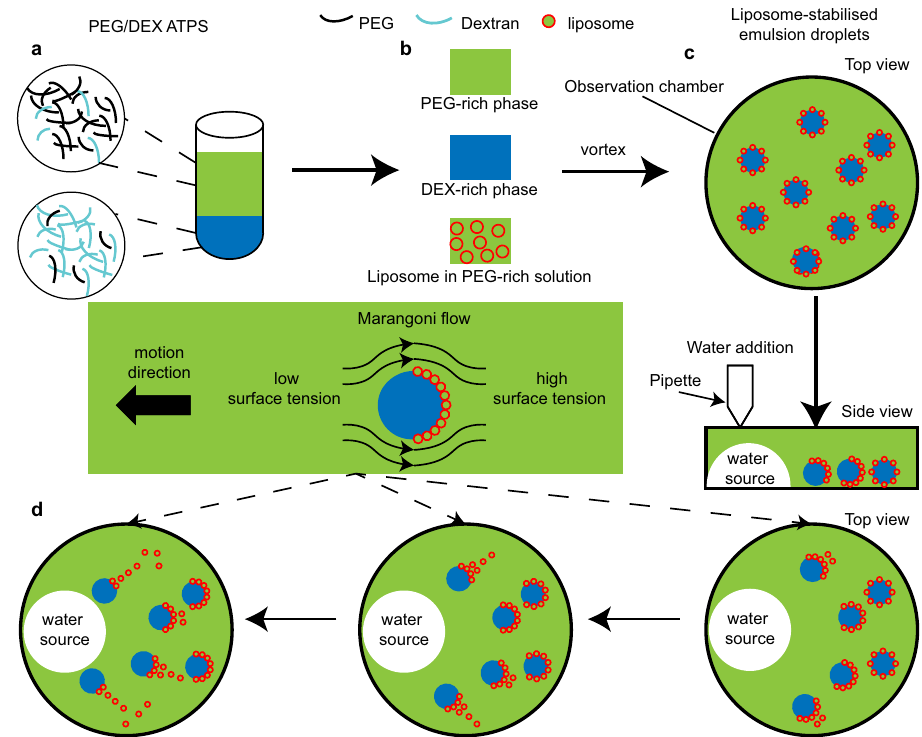
Fig. 1 Engineering motile aqueous phase-separated droplets via liposome stabilisation. a PEG (polyethylene glycol)/DEX (dextran) solution separates into PEG-rich and DEX-rich phase to form ATPS (aqueous two-phase system). b Preparation of liposome in PEG-rich solution. c Preparation of emulsion droplets by mixing PEG-rich phase, DEX-rich phase and liposomes via vortex. d Droplets achieve directional motion towards the water source in response to a polymer gradient caused by the addition of